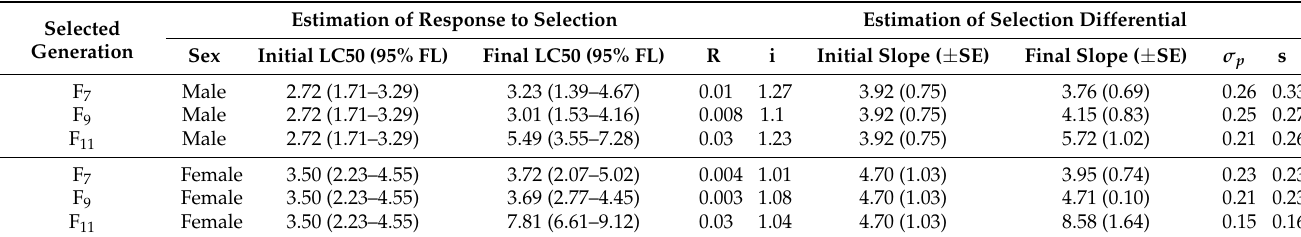
Table 4. Estimation of response to selection ( R ) and selection differential ( S ) of malathion-selected adult population of D. suzukii . Selected